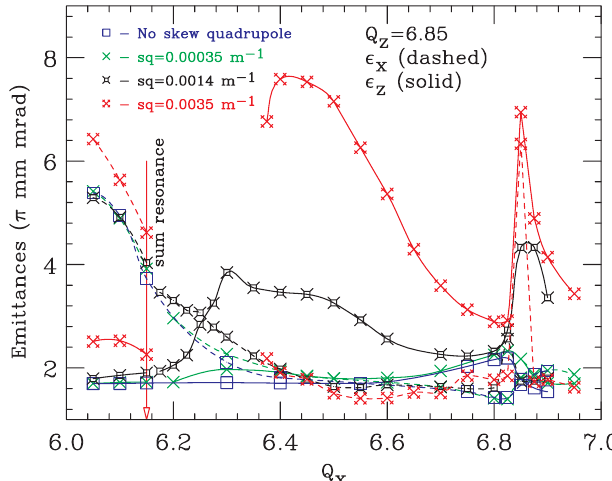
FIG. 32. (Color) The emittance evolution for a beam with 12- turn injection when the space-charge force and random skew- quadrupole kicks are included. The importance of the linear- coupling (sum and difference) resonances are clearly visible when the amplitude of skew quadrupole is large. Note that the random skew-quadrupole error also introduces stop band width to integer resonances.